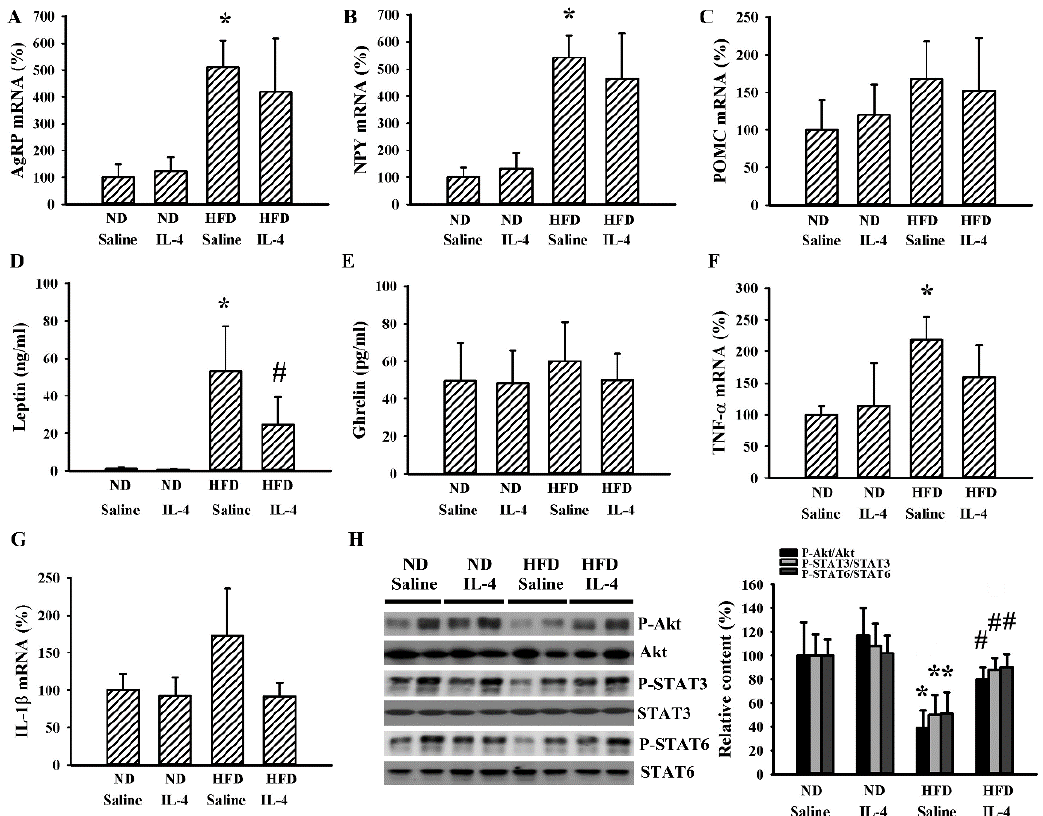
Figure 7. IL-4 ameliorated hypothalamic changes in leptin-resistant mice. C57BL / 6 mice were fed the normal diet (ND) or high-fat diet (HFD) for 12 weeks. Simultaneously, normal saline and IL-4 (1 µ g / mouse) were intraperitoneally administrated twice a week for the last 8 weeks. Total RNA were extracted from the hypothalamic tissues and mRNA expressions measured with qRT-PCR for AgRP ( A ), NPY ( B ), POMC ( C ), TNF- α ( F ), and IL-1 β ( G ). Blood samples were collected and leptin ( D ) and ghrelin ( E ) levels measured with ELISA. Proteins were extracted from the hypothalamic tissues and subjected to Western blot analysis with indicated antibodies. Representative blots and quantitative data are shown ( H ). * p < 0.05 vs. ND/saline group and # p < 0.05 vs. HFD/saline group, n = 6.